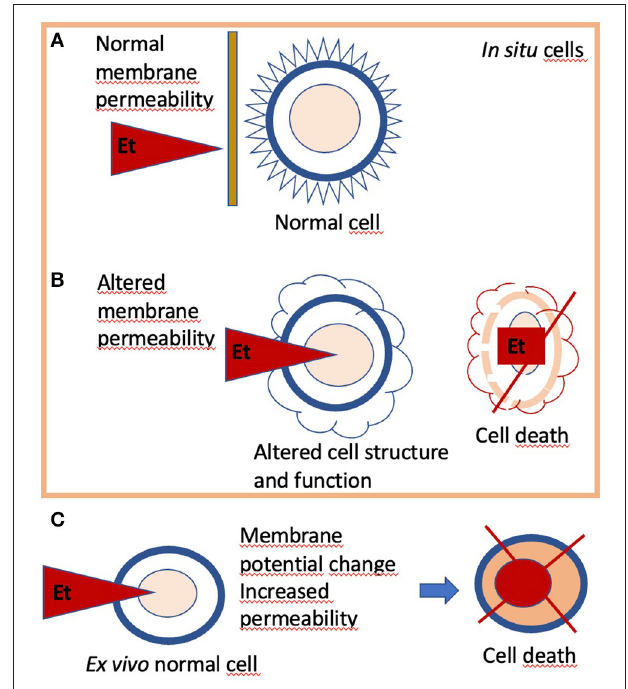
FIGURE 7 | Proposal for the action of the aqueous extract of Caesalpinia spinosa (Et). An Et compound has cytotoxic and genotoxic action. The limiting action of this effect is that a normal cell is not permeable for the entry of Et and is therefore not affected (A) . However, if the structure of the membrane is modified, as occurs in a neoplastic cell, Et will enter and cause cell death (B) . In the case of ex vivo or in vitro tests, the cells being outside the individual will change their cellular permeability; the Et will enter the intercellular space and produce cell death, according to the dependent dose, as demonstrated in this research and previous reports of in vitro tests (C)